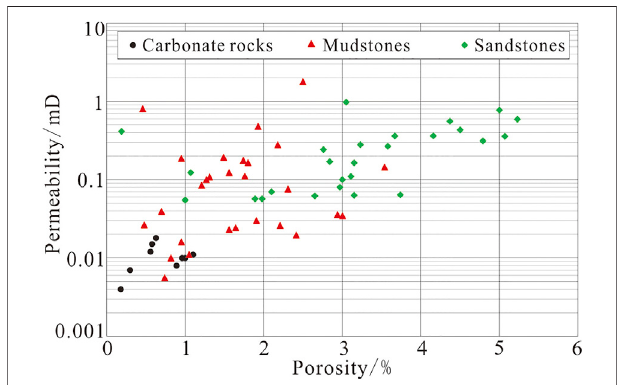
FIGURE 7 | Cross-plot of porosity vs. permeability of the studied